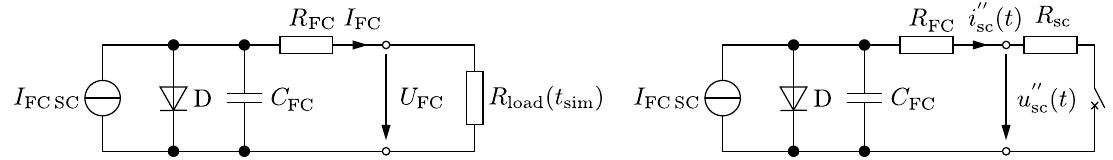
Figure 12. Configurations of the two simulations to validate the model: ( left ) stationary simulation model for the polarization curve, ( right ) model for the transient behavior during a short circuit. Equation (32) represents the load for a simulation time of t sim = 100 s.